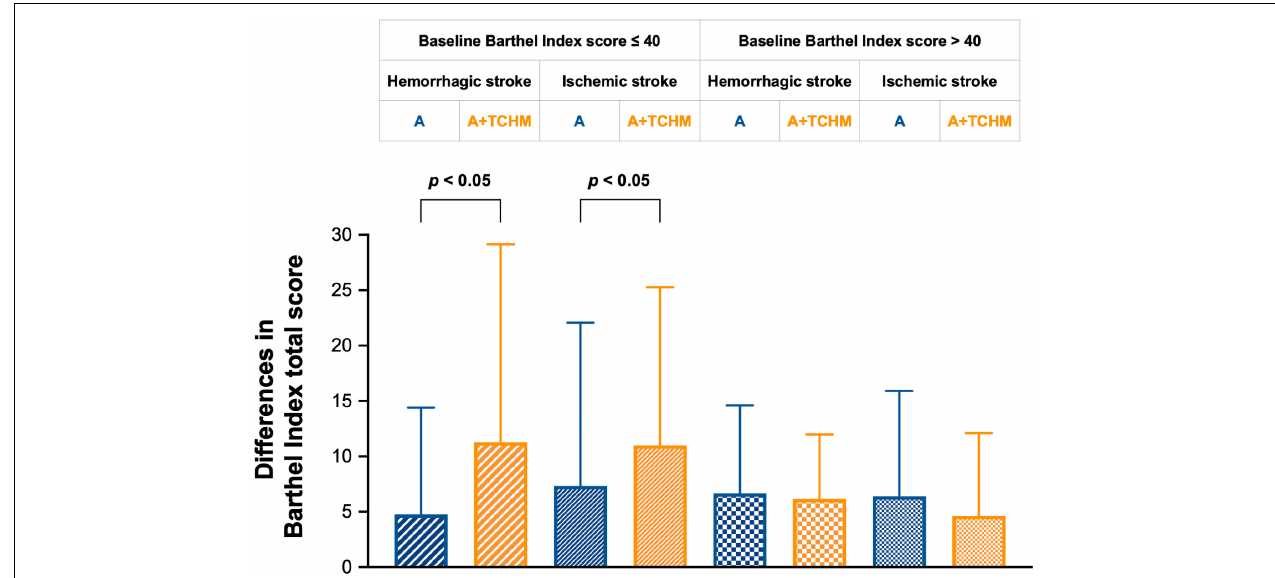
FIGURE 3 | Subgroup analysis by baseline BI score